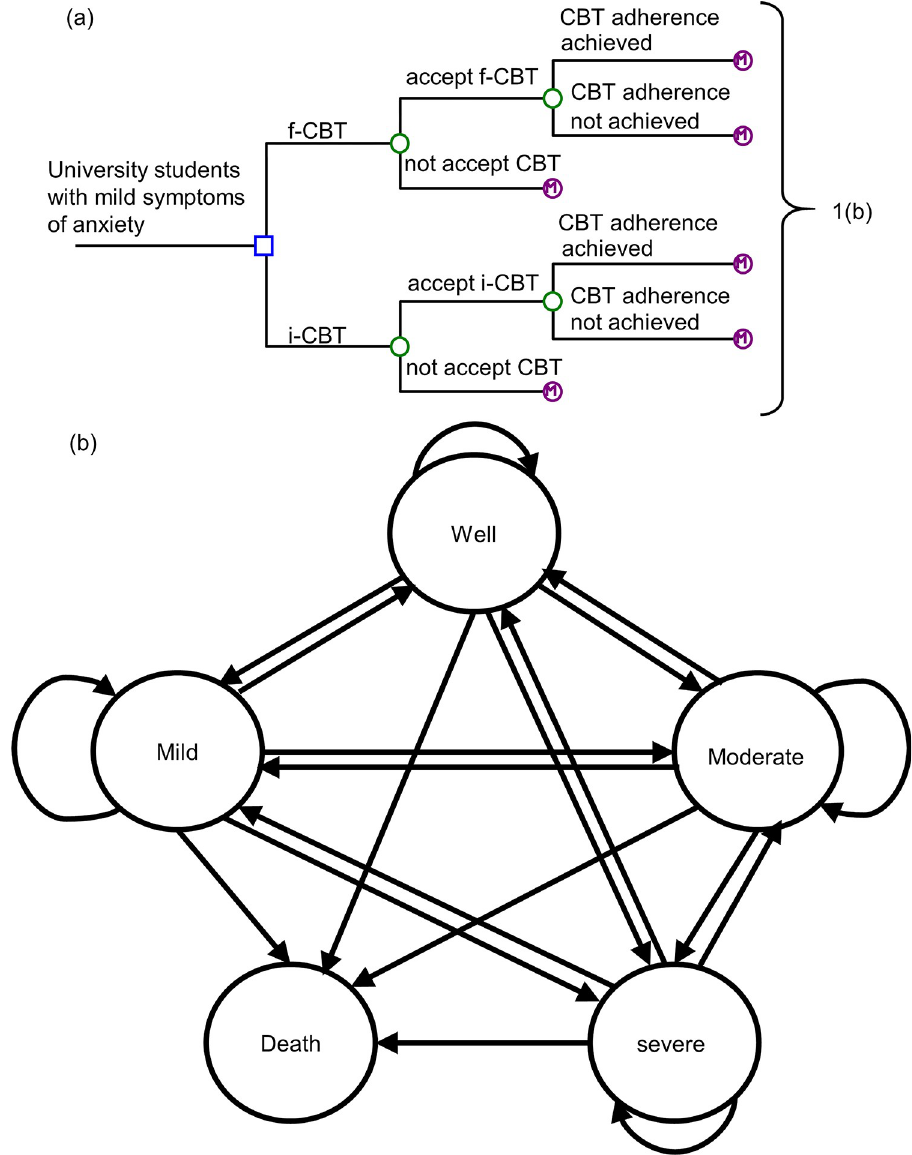
Fig 1. a, b. Simplified Markov model of university students with mild symptoms of anxiety. CBT: cognitive-behavioral therapy; f-CBT: face-to-face cognitive-behavioral therapy; i-CBT: internet-based cognitive-behavioral therapy.